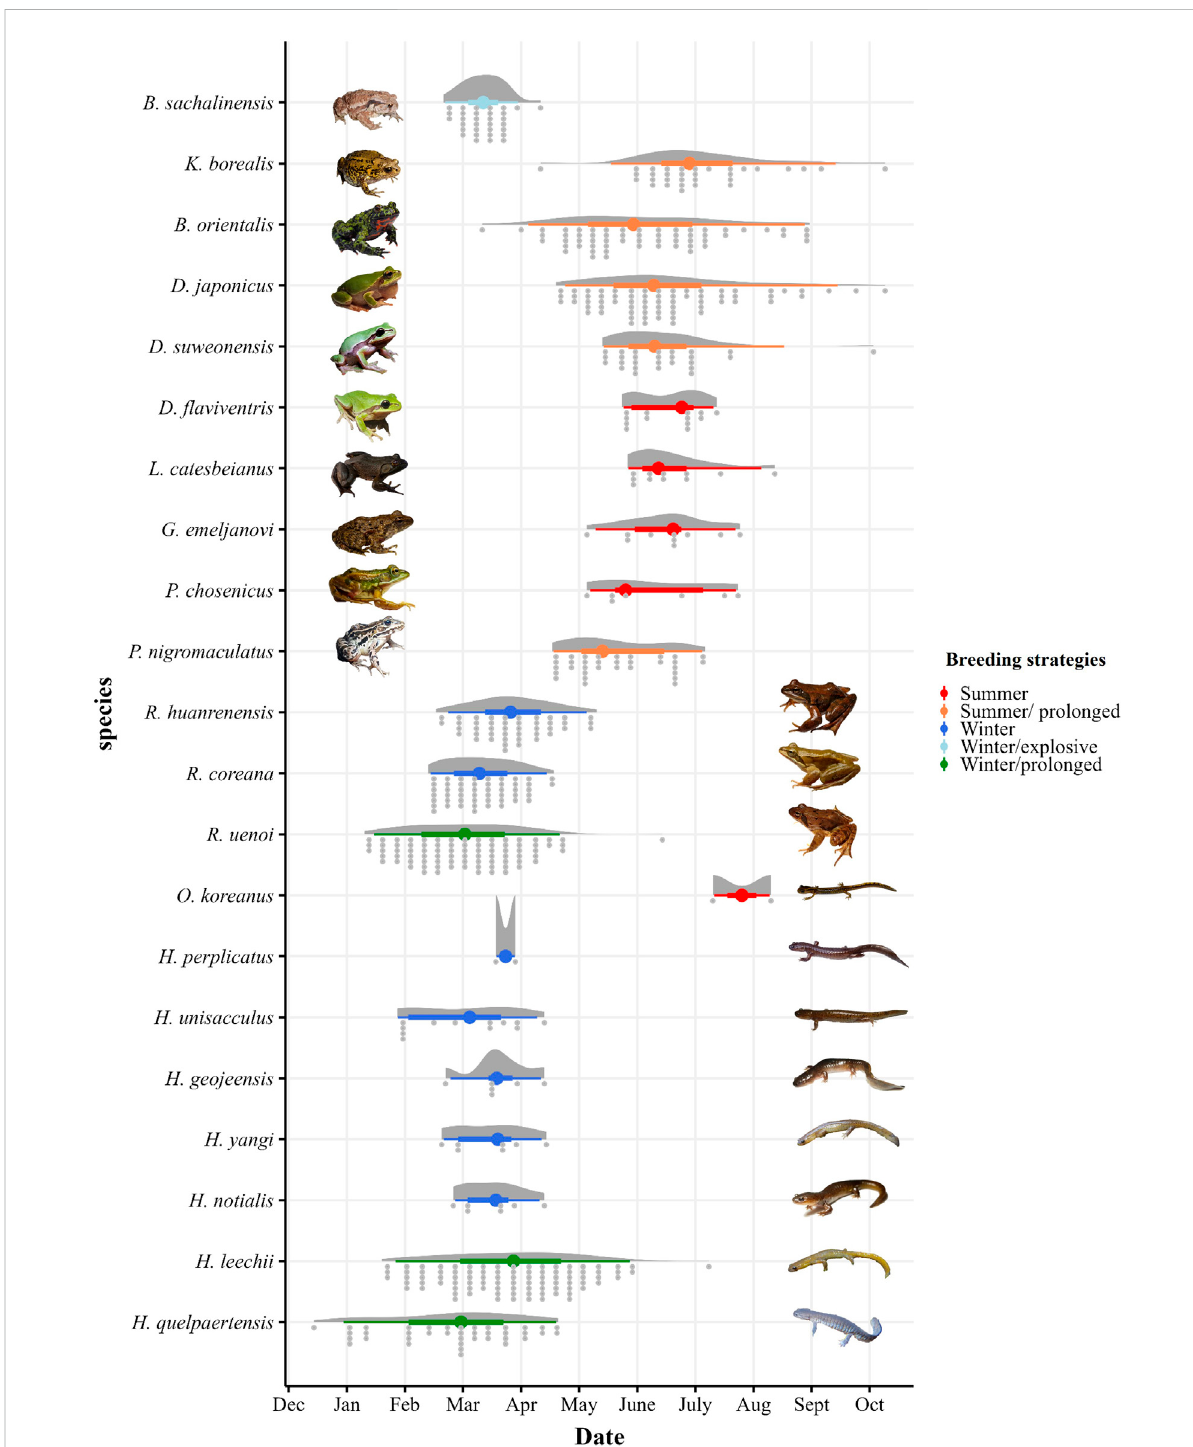
FIGURE 1 Distribution of the proportion of the observed breeding behaviour (amplexus, eggs, and/or calling), including outliers, based on 8,763 citizen scienceobservationsdownloadedfromiNaturalistfor D. fl aviventris ( n =18) ,D.suweonensis ( n =41) ,D.japonicus ( n =421) ,B.sachalinensis ( n =131), B.orientalis ( n =100), K.borealis ( n =48), R.coreana ( n =136) ,R.uenoi ( n =695) ,R.huanrenensis ( n =222), G.emeljanovi ( n =14), P.nigromaculatus ( n = 63), P. chosenicus ( n = 7), and L. catesbeianus ( n = 13), H. geojeensis ( n = 26) , H. perplicatus ( n = 14) , H. notialis ( n = 14), H. quelpaertensis ( n = 125), H . unisacculus ( n = 23), H. yangi ( n = 15), H. leechii ( n = 306), and O. koreanus ( n = 6) in the Republic of Korea. The data was collected between 02 March 1997 and 01 December 2020. Boxplots indicate the median, interquartile range (IQR), and 1.5*IQR, boxplot colours indicate the different breeding strategies (summer, summer/prolonged, winter, winter/prolonged, winter/explosive,